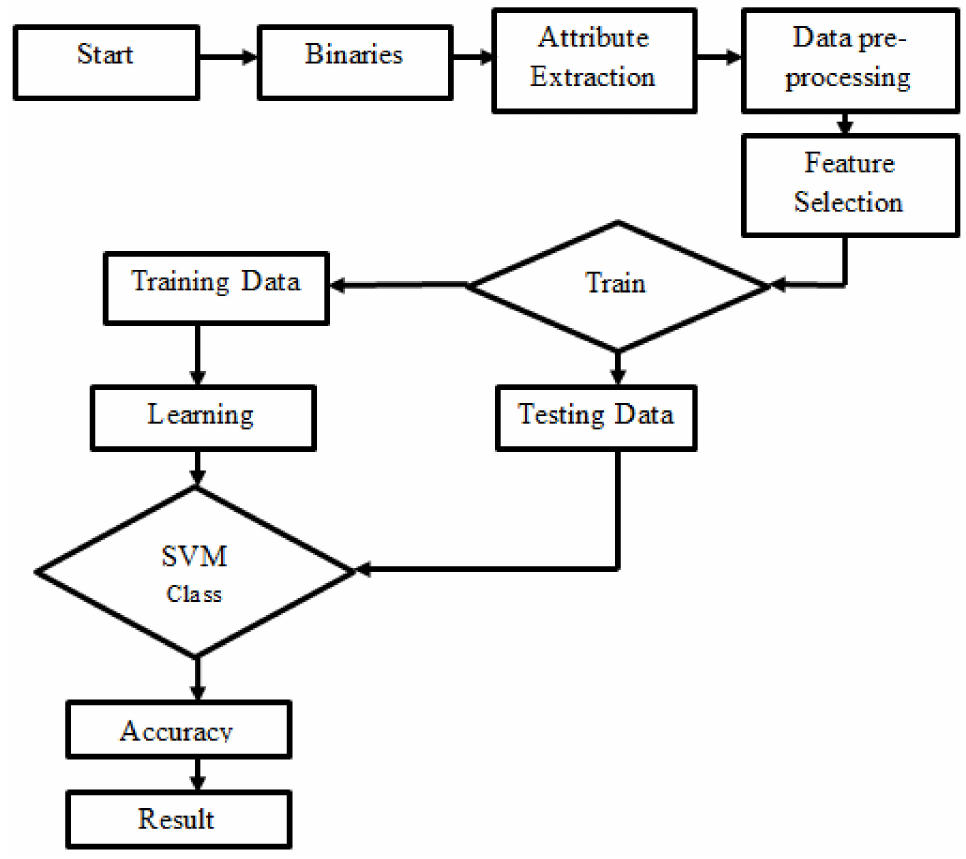
Figure 5. Flow diagram for malware detection and classification using artificial intelligence